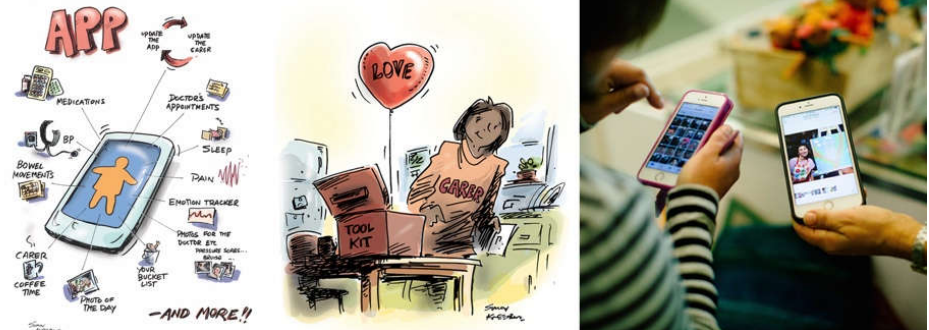
Figure 2. Visual representation of the app, carer’s toolkit, and discussing